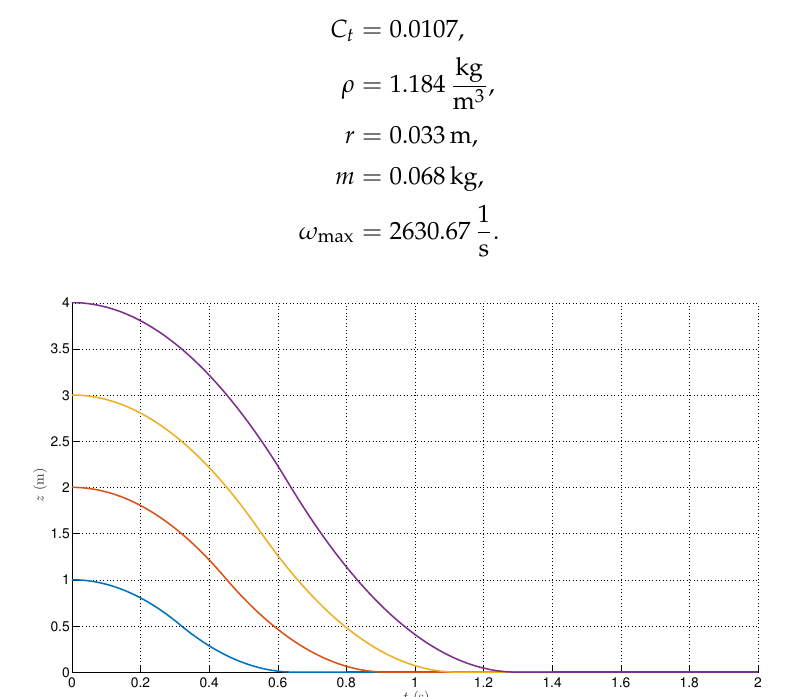
Figure 2. Minimum-time trajectories (for various initial altitudes—see the values at t =